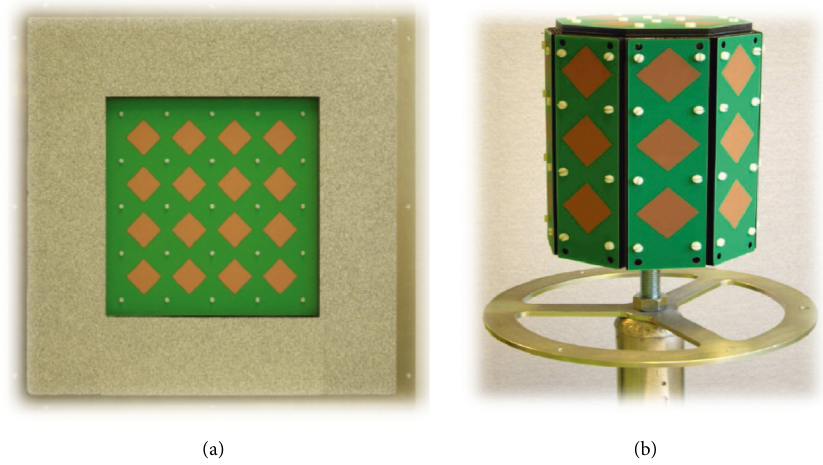
Figure 2: Antenna arrays. (a) TX antenna: UPA. (b) RX antenna: ODA.